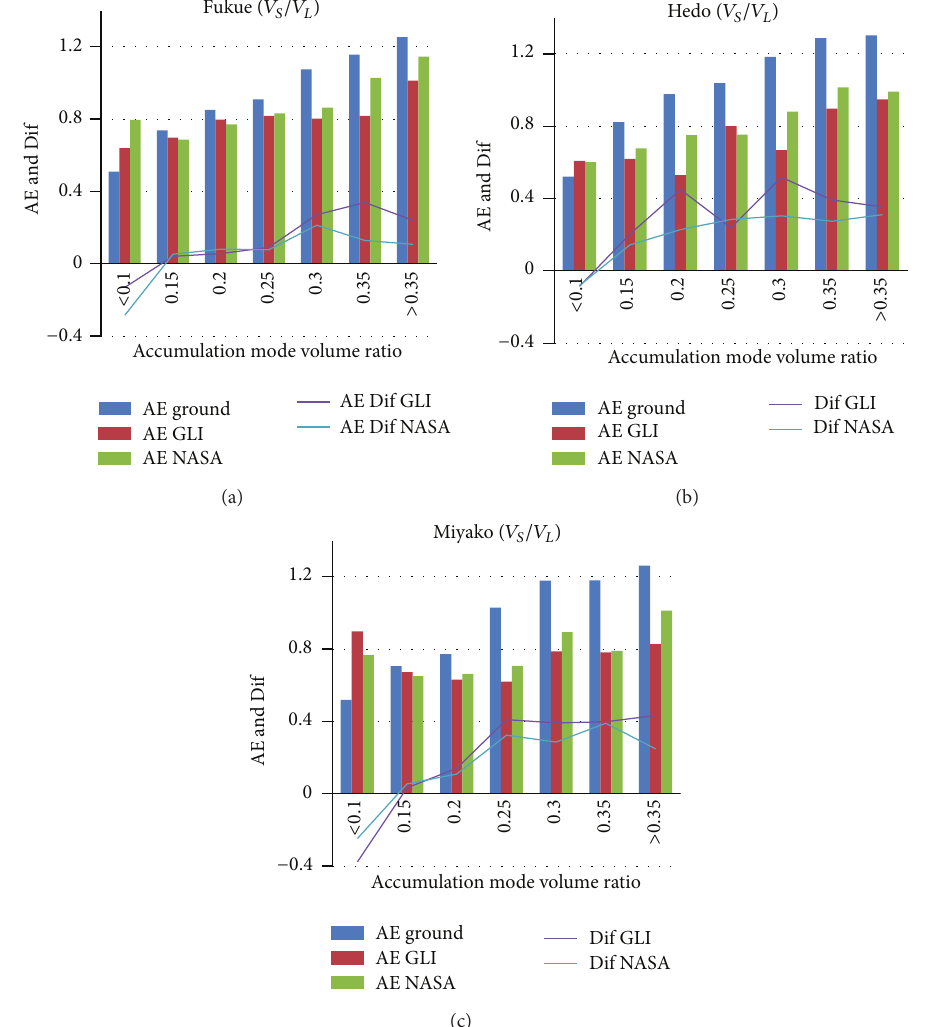
Figure 7: AE and AE difference (ground-satellite) against the accumulation mode volume ratio ( 𝑉 𝑆 /𝑉 𝐿 ) variation.